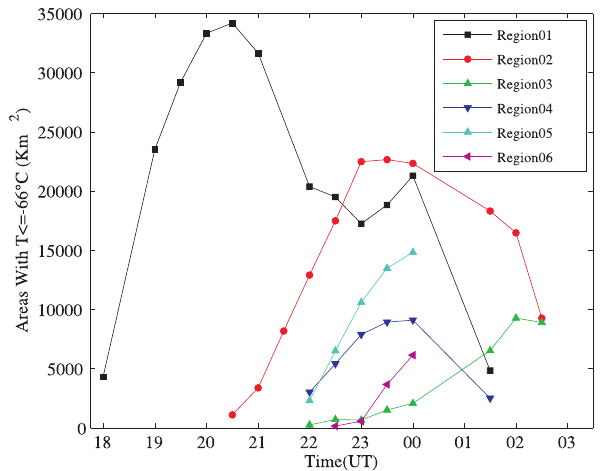
Fig. 4. Temperature profile of the atmosphere at Braslia (15.86S, 47.93W) showing an average tropopause temperature of − 76 ◦